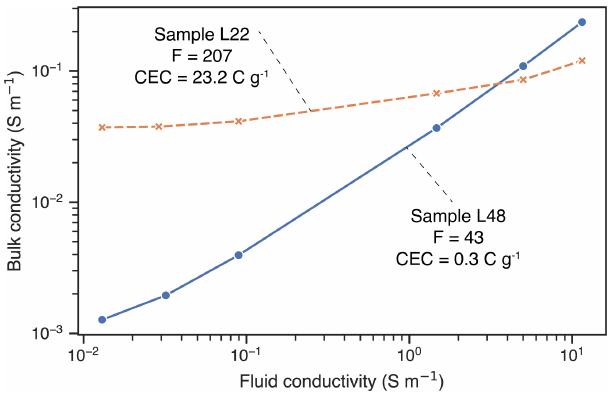
Figure 7. Results from electrical measurements at 1kHz versus fluid conductivity for two samples from Lévy et al. (2018) with different electrical properties. The formation factor ( F ) and cation exchange capacity (CEC) for the two samples are